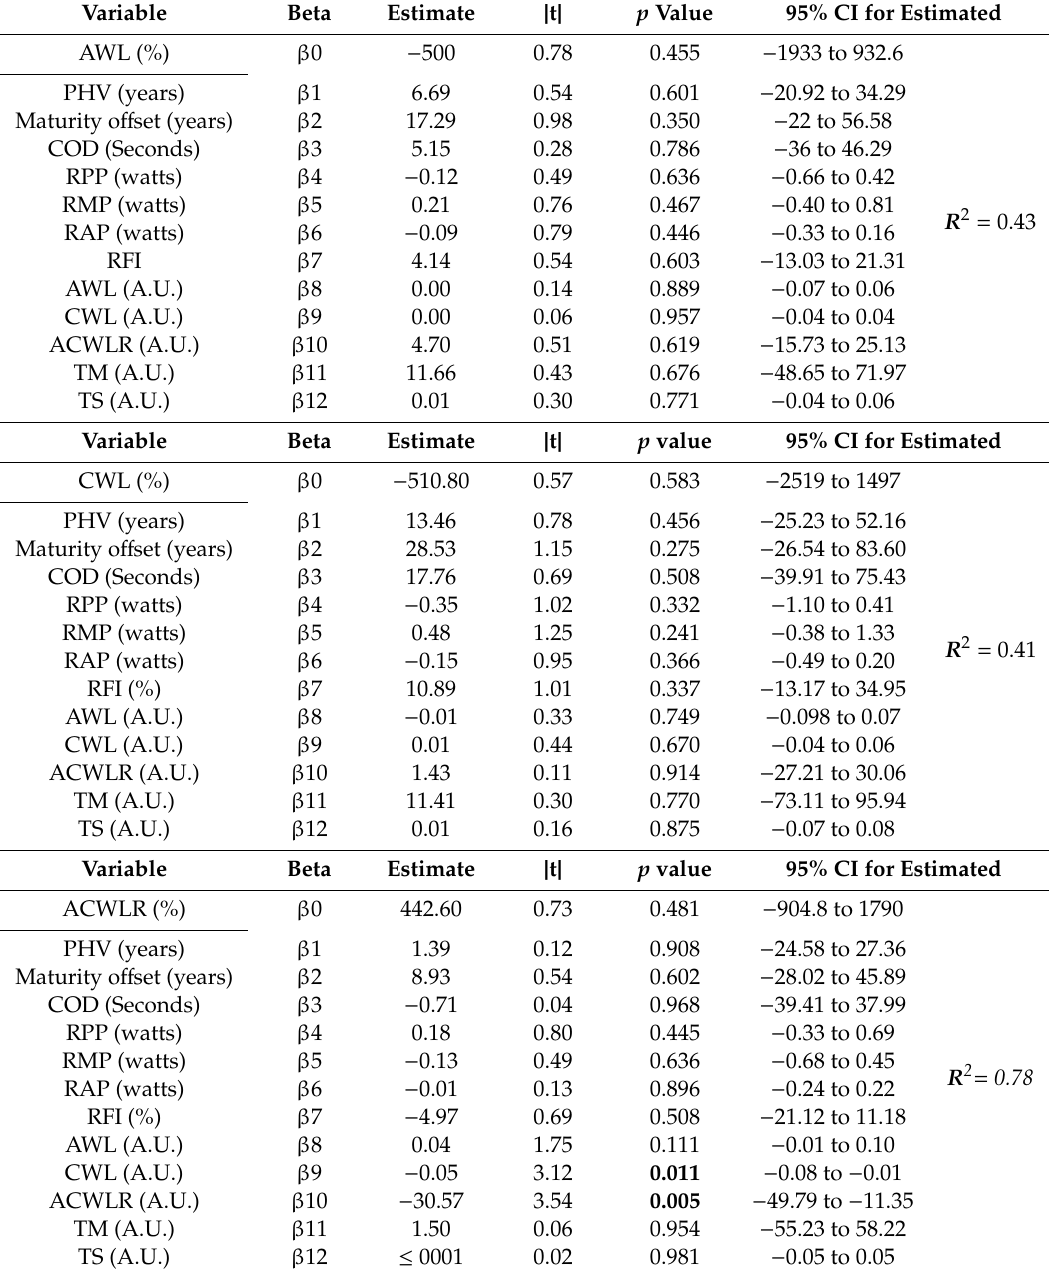
Table 4. Multiple linear regression analysis: percentage of change between EaS and EnS in AWL, CWL, and ACWLR with workload parameters, baseline fitness levels, and